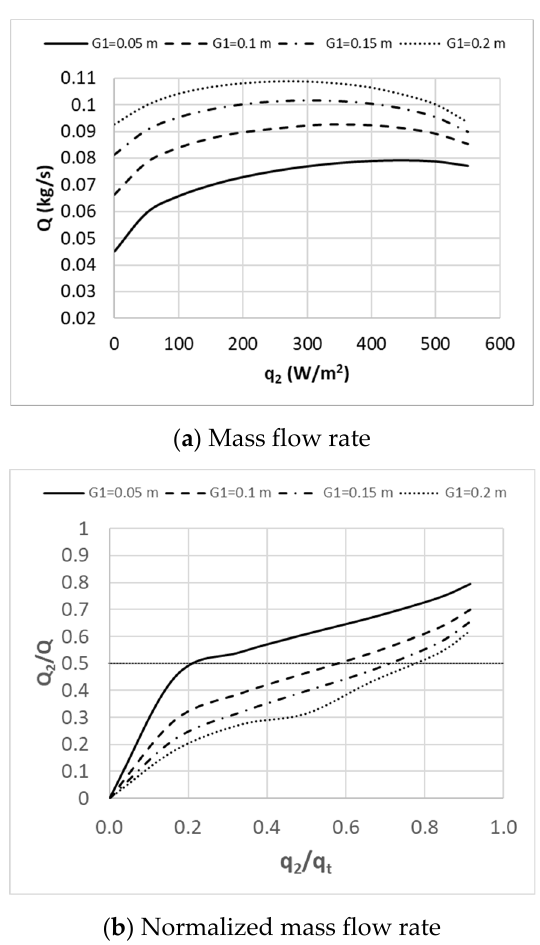
Figure 6. Mass flow rate of Configuration (II) ( 𝐺 (cid:2870) = 0.1 𝑚 ) at different values of 𝑞 (cid:2870) and 𝐺 (cid:2869) .